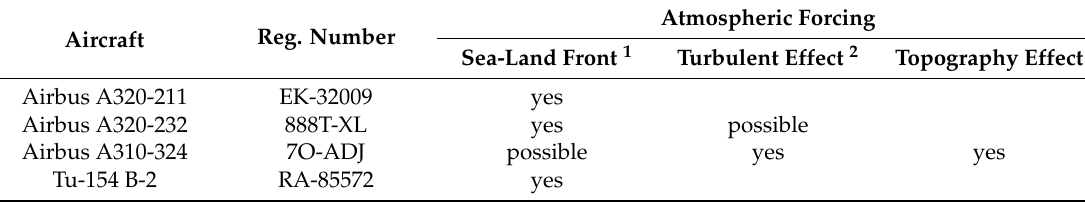
Table 3. The atmospheric forcing to aviation